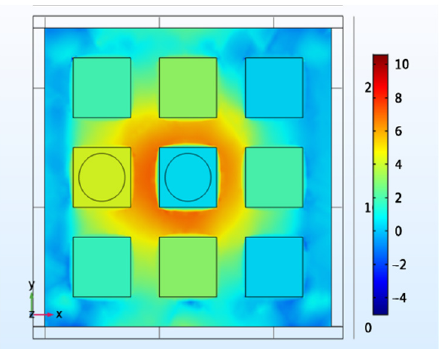
Figure 12. The response when the touch events are applied to adjacent locations simultaneously [9]